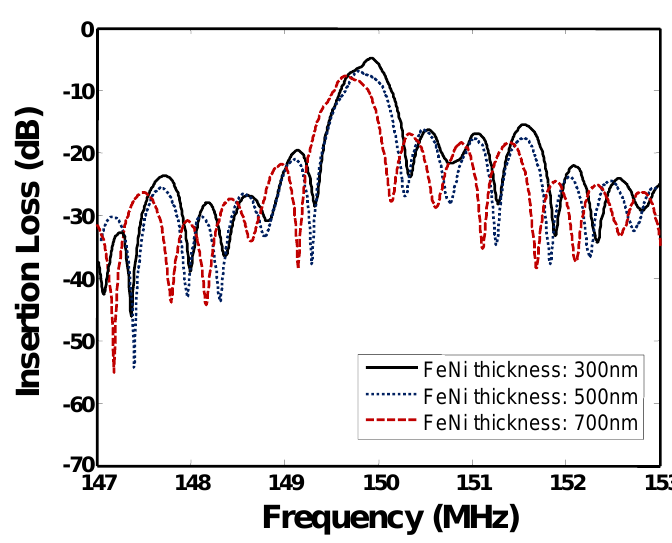
Figure 8. The observed surface morphology of the FeNi coating.